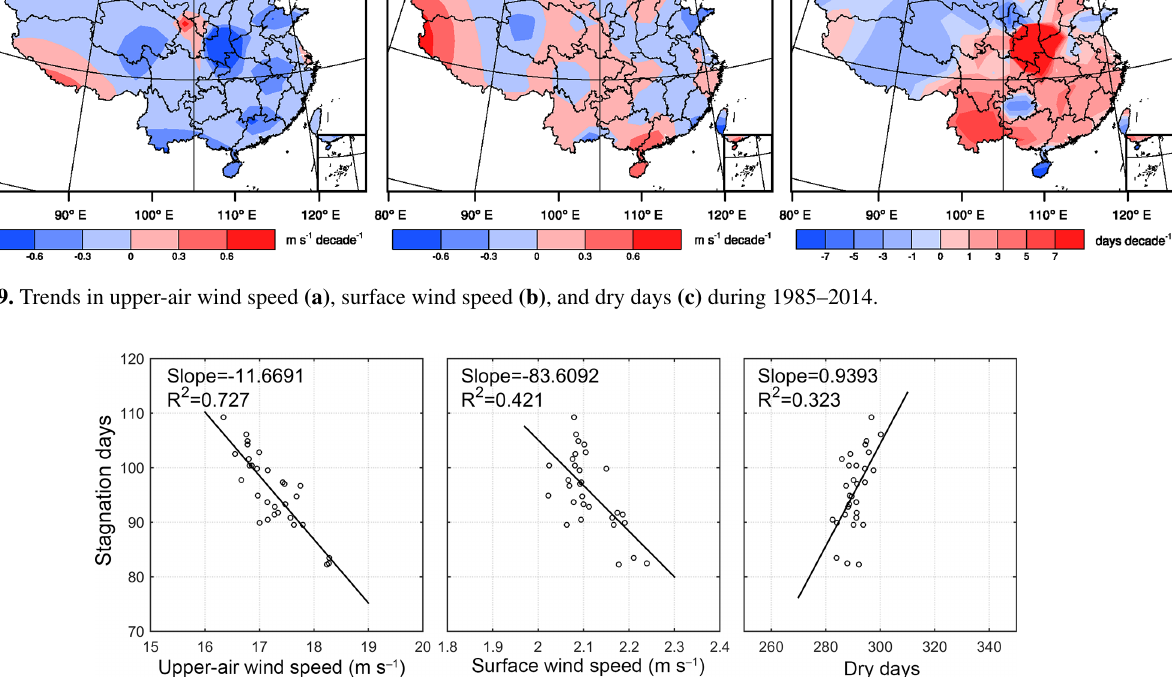
Figure 10. Same as Fig. 8, but for the trends in stagnant days. Linear regression coefficients between nationally averaged stagnant days in the 30-year period and each corresponding component are